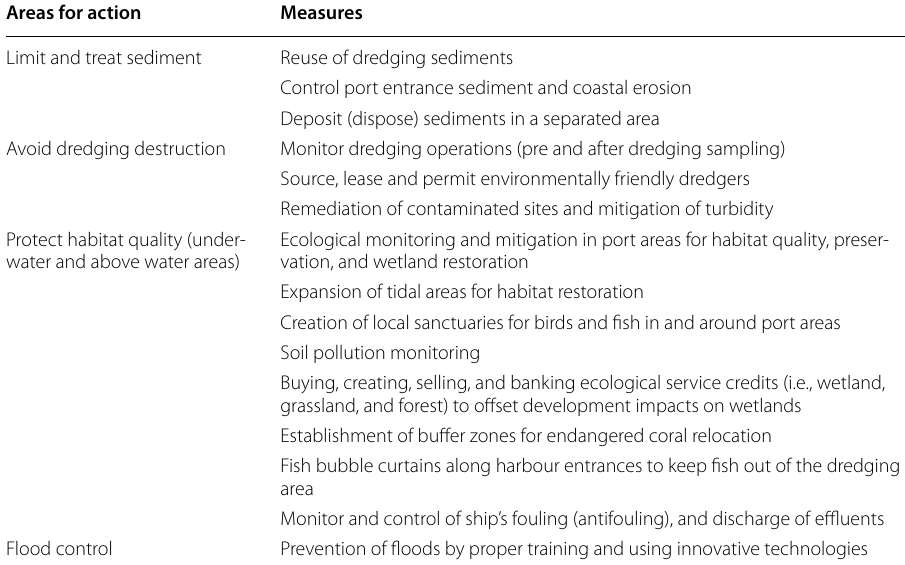
Table 4 Marine biology conservation actions and measures. Sources : I2S2 (2013), Lirn et al. (2013), Shiau and Chuang (2013), Yang and Chang (2013), Chiu et al. (2014), PIANC (2014), Roh et al. (2016), Laxe et al. (2017), Oh et al. (2018) and Lim et al. (2019) Areas for